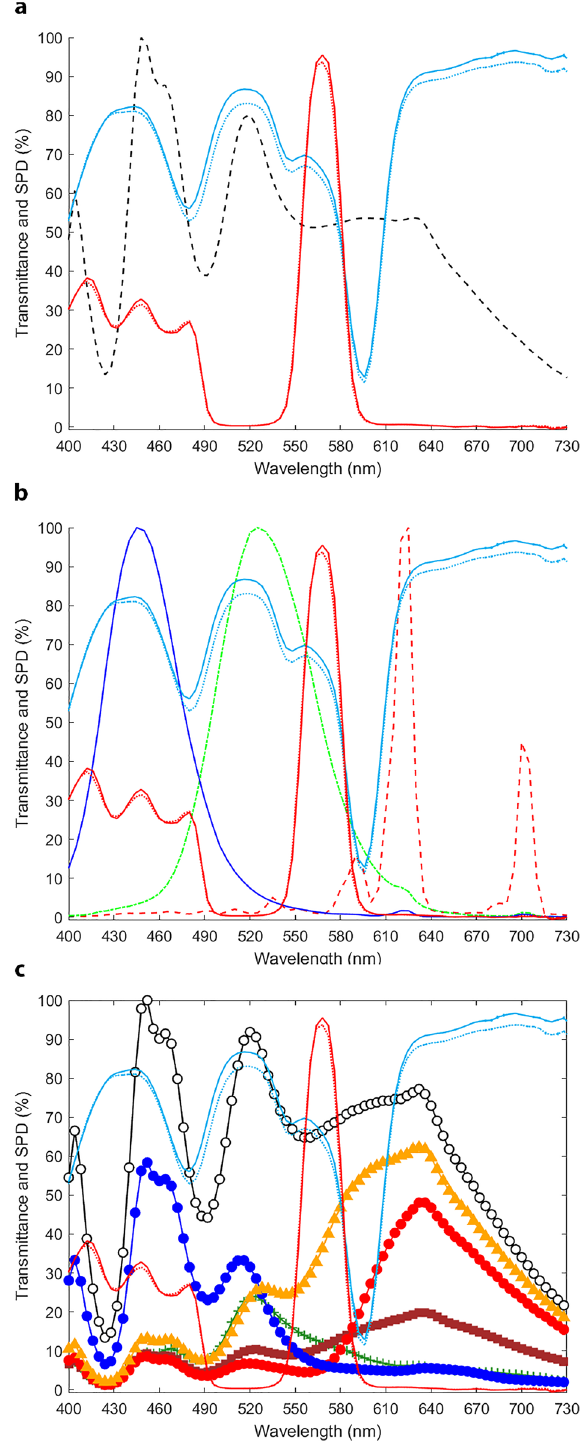
Figure 1. Transmittance spectra for filters and spectral power distribution for lighting, screen guns and sorting pieces. Average transmittance spectra (in arbitrary units) of the filters (red lines for Variantor; blue lines for EnChroma; solid lines for filter to right eye, dotted lines for filter to left eye) in panels ( a ), ( b ) and ( c ) and average spectral power distribution (SPD): of the D65 light source (black dashed line) in panel ( a ); of screen guns of the Sony-GDM F520 (red dashed line for red gun; green dotted-dashed line for green gun and dark blue solid line for blue gun) in panel ( b ); and of the sorting pieces (black solid line with white circles for white pieces; blue solid line with blue circles for blue pieces; orange solid line with orange triangles for orange pieces; red solid line with red circles for red pieces; brown solid line with brown squares for brown pieces; green solid line with green crosses for green stimuli) as radiance in panel ( c ). Error bars indicate ± 1 standard error of the mean (SEM) across three measurements of filter transmittance and of the spectral power distribution (SPD) of the D65 light. If not visible, error bars in terms of repeatability of measurements from 400 to 730 nm are within the line/symbol